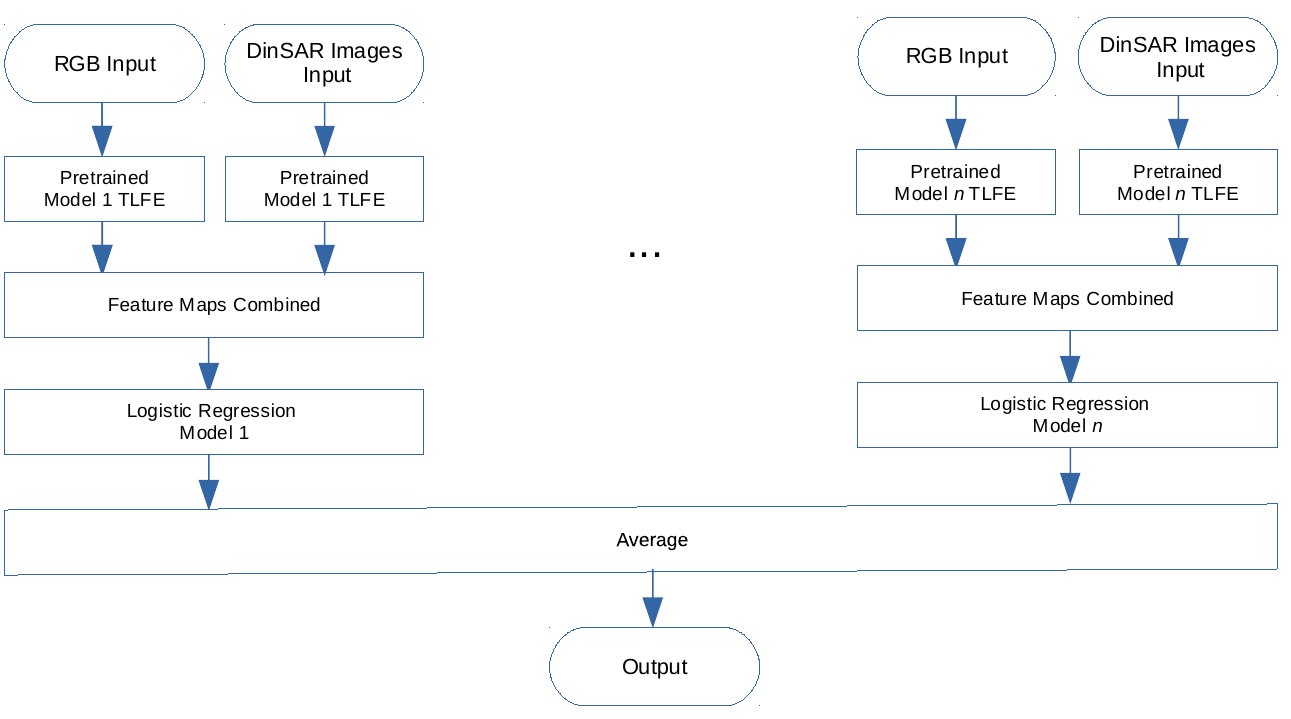
Figure 3. General form of the architecture of the AvgEnsNet family of transfer learning by feature extraction neural